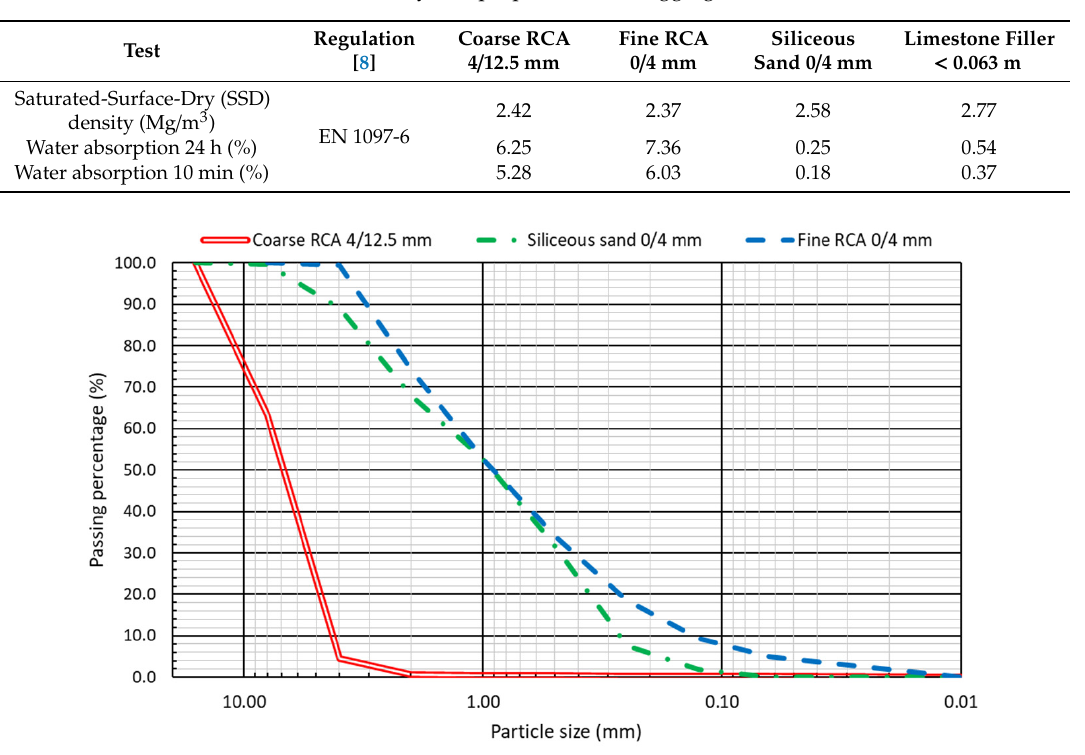
Table 1. Physical properties of the aggregates.